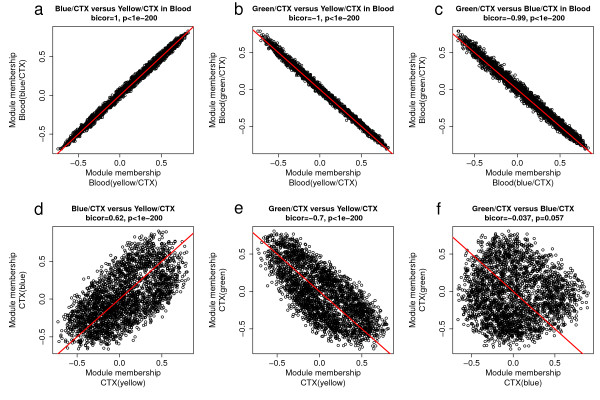
Relationships between the module membership measures of the three preserved cortex modules. Relationships between the module membership of blue/CTX, yellow/CTX and green/CTX modules in blood (a-c) and in the original cortex brain samples (d-f). Panel (a) shows that the correlation between MMyellow and MMblue equaled 1 in the blood data, which reflects the fact that these modules were indistinguishable in blood. In contrast, panel (d) shows that correlation between MMyellow and MMblue equaled 0.62 in cortex. Figure (b-c) shows that MMgreen had a correlation close to -1 with MMyellow (b) and MMblue (c) in blood. We report both uncorrected correlation test p-values and Bonferroni corrected p-value (inside of brackets). Given the very high correlations between MMgreen, MMyellow, and MMblue in blood, we combined the three measures in an overall module membership measure referred to as MM.combined.Blood. Analogously, we combined the three MM measures for the cortex network (referred to as MM.combined.CTX).